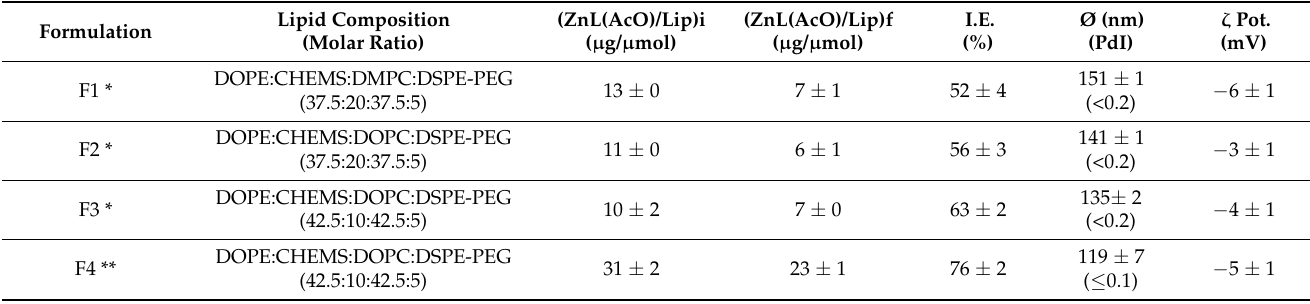
Table 2. Physicochemical characterization of the [ZnL(AcO)] nanoliposomes.